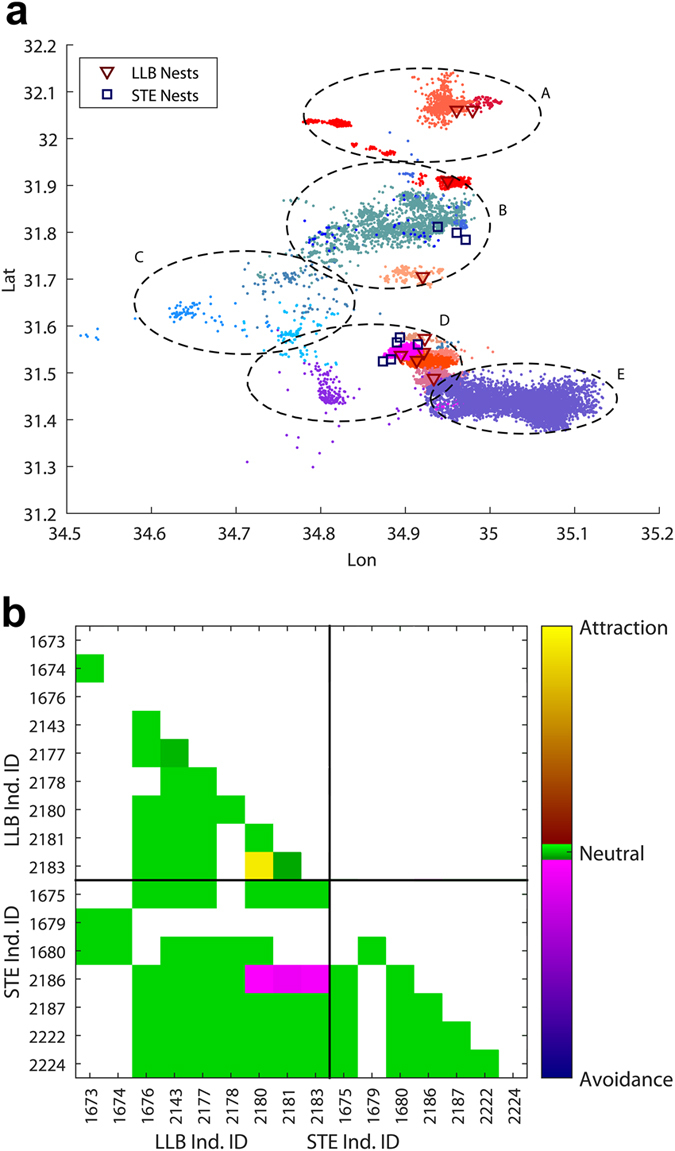
(a) Clustering of individual birds’ foraging locations. We have identified 5 significant foraging-locations clusters (dashed ellipses, labeled A–E). The foraging locations of each individual are marked by colored dots, with LLB individuals in “warm” shades (magenta-red-brown) and STE individuals in “cool” shades (violet-blue-grey). Nest location for each individual are marked by a triangle (LLB) or a square (STE). Cluster analysis to group foraging locations was conducted using the k-means function in MATLAB. (b) Results of attraction-repulsion analysis of movement patterns between each pair of individual birds using MoveMine49. Individual bird IDs are listed and sorted by species. The figure is symmetric across the diagonal. Color marks the attraction index, varying from 0 (complete avoidance) through 0.5 (mutually random movement pattern) to 1 (complete attraction, coordinated, matching movement patterns). A white (blank) square indicates that these two individuals were never observed at the same year. Most individuals display neutral movement patters to each other, except three LLB individuals that display avoidance toward STE individual 2186, and one pair of LLBs (2183 and 2180) that show matching (attracted) movement patters. This figure was plotted using MATLAB (Mathworks, Natick, MA) version R2015b (http://www.mathworks.com/products/matlab/).